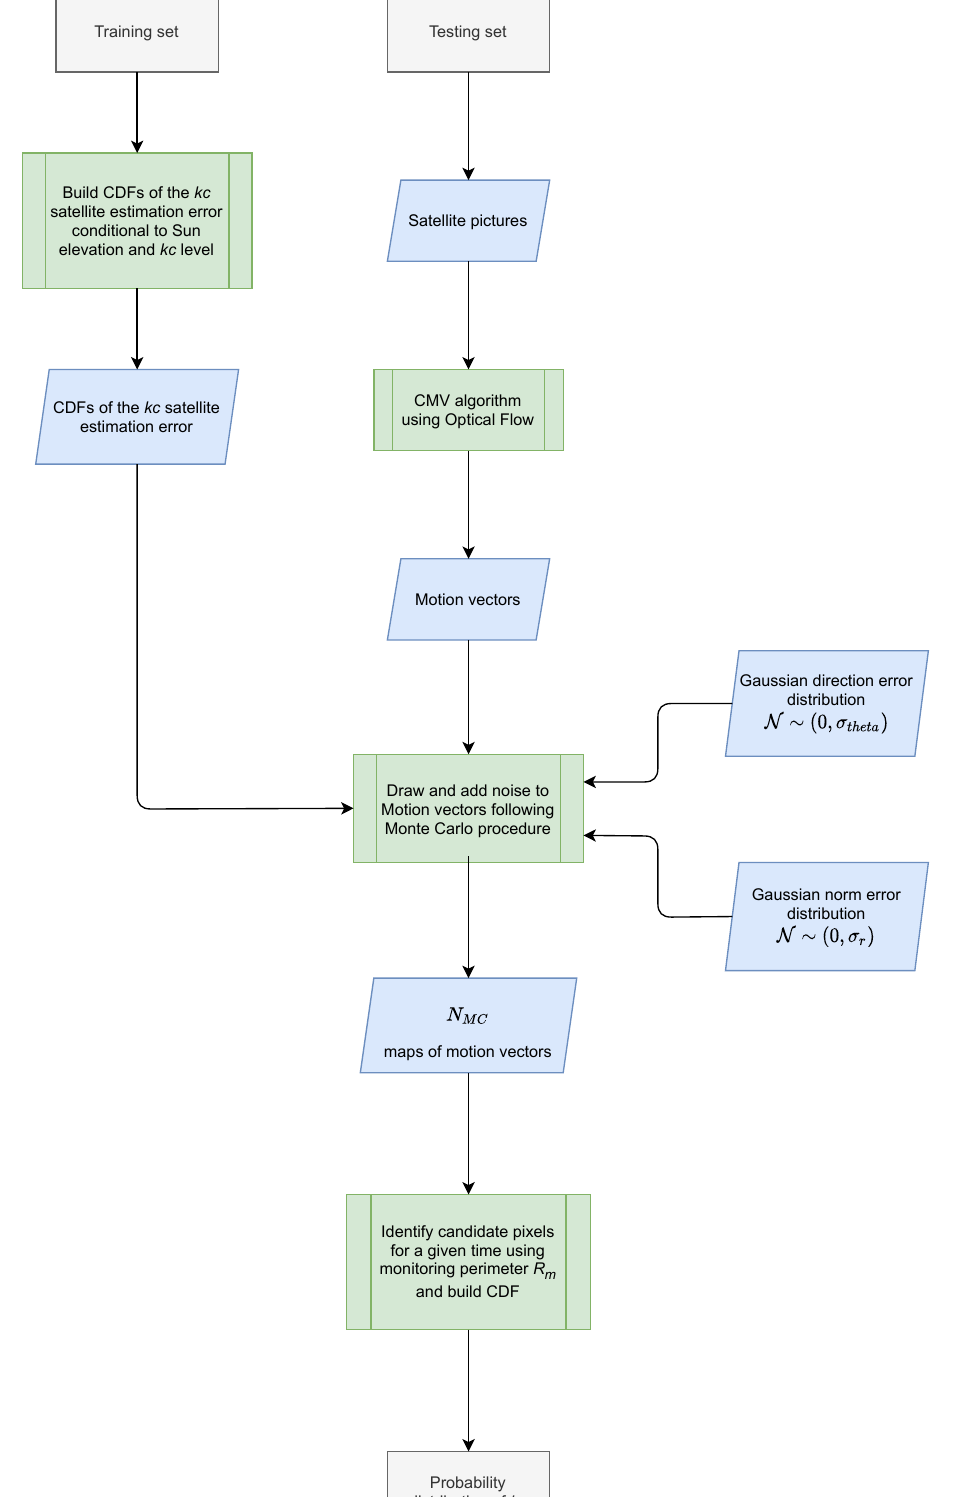
Figure 2. Overall flowchart of the probabilistic CMV forecasting